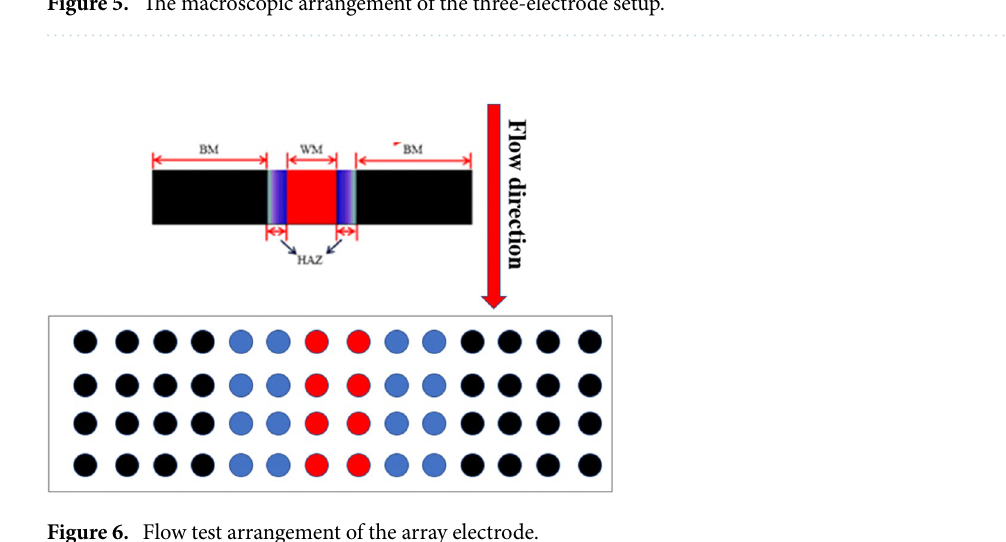
Figure 6. Flow test arrangement of the array